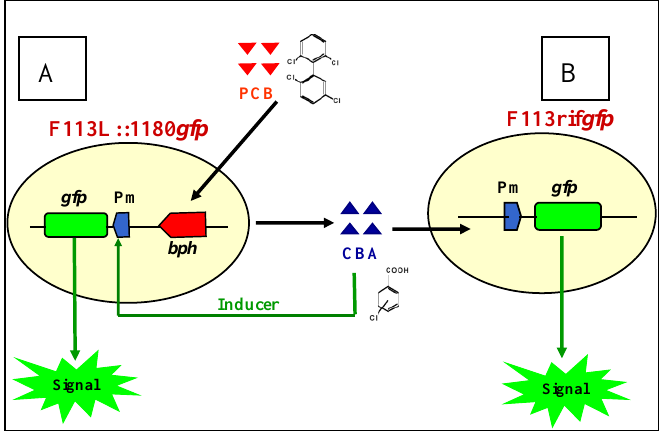
Figure 5. The use of two PCB biosensors. (A) F113L::1180 gfp is able to report its own biodegradation of PCBs by switching on the signal, and the biodegradation of chlorobenzoic acid (CBA) by other CBA degraders by switching off the signal. (B) F113rif gfp is able to sense the biodegradation of PCBs by other PCB degraders by switching on the signal and the biodegradation of CBA by other CBA degraders by switching off the signal